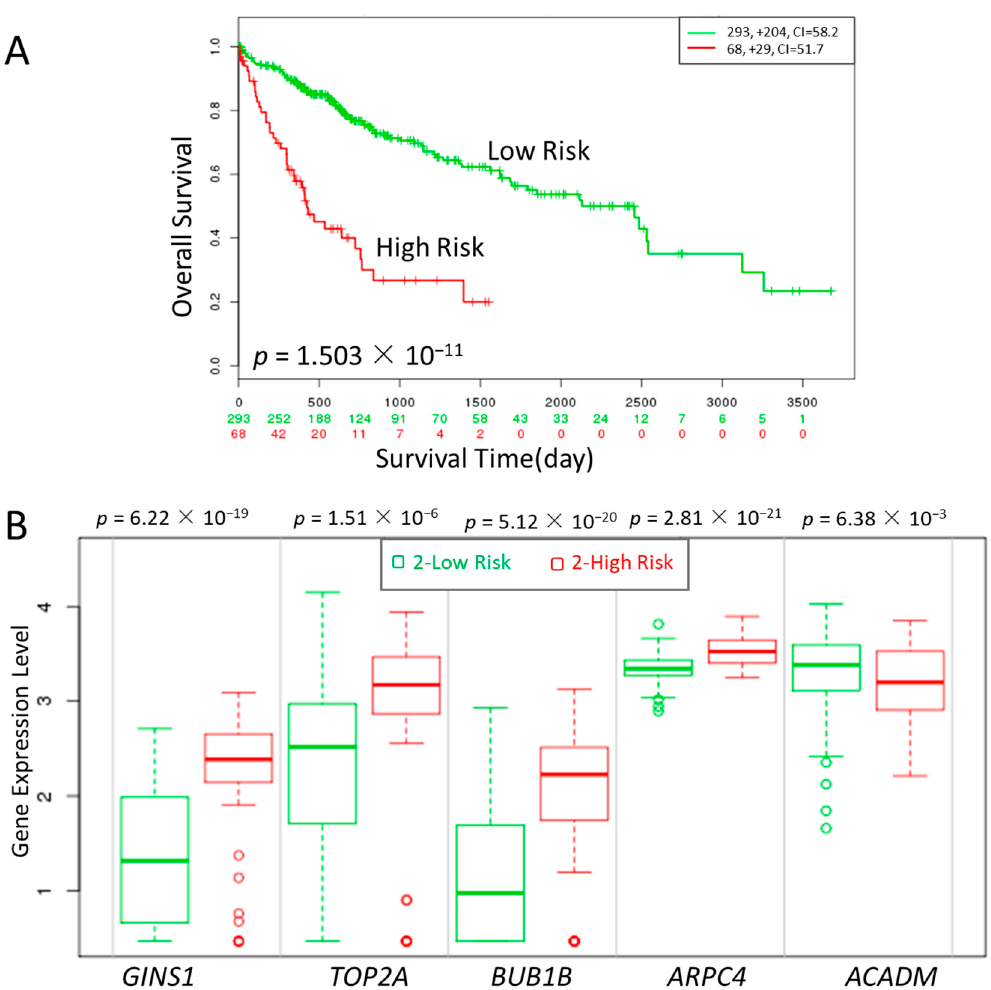
Figure 6. Kaplan-Meier curves of gene groups ( GINS1 , TOP2A , BUB1B , ARPC4 , ACADM ) in The Cancer Genome Atlas (TCGA) liver cancer dataset based on SurvExpress ( n = 381). “+” marks on the upper figure represents censoring samples. Horizontal axis represents time (day) to event. Outcome event, time scale, concordance index (CI) and p value of the log-rank test are shown. Red and green curves represent High- and Low-risk groups, respectively. The number below the horizontal axis represents the number of individuals not presenting the event of the corresponding risk groups over time. ( A ) The xpression of five genes is correlated with high risk, poor prognosis and shorter overall survival time. ( B ) box plot of the five genes across risk groups with the p value.